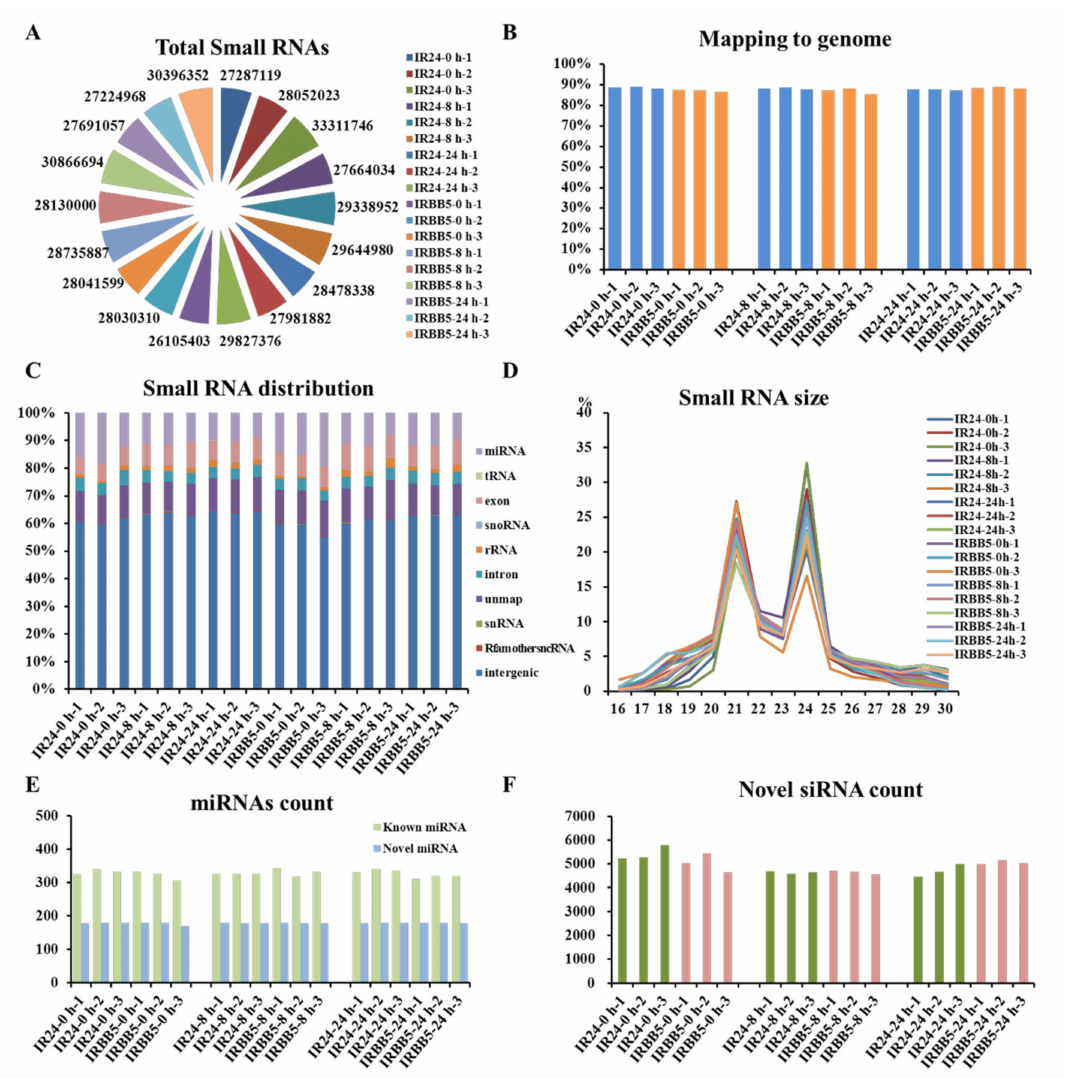
Figure 2. Profiling of small RNA sequencing in two rice genotypes inoculated with Xoo strain PXO86. ( A ) Total clean reads distribution in libraries from di ff erent time point treatment with Xoo strain PXO86. ( B ) The mapping percentage of the clean reads in 18 sequenced samples. ( C ) The classification distribution of the sequenced small RNA for every rice small RNA library. ( D ) Length distribution and abundance of the small RNAs in each library. ( E ) The statistic of known and candidate miRNAs in disparate sample. ( F ) The distribution number of predicted siRNAs in disparate sample. ‘IR24 (cid:48) represents the rice cultivar ‘IR24 (cid:48) ; ‘IRBB5 (cid:48) represents the rice cultivar ‘IRBB5 (cid:48) ; ‘0 h’, ‘8 h’ and ‘24 h’ represents separately the treatment time point with Xoo strain PXO86; ‘ − 1 (cid:48) , ‘ − 2 (cid:48) and ‘ − 3 (cid:48) means the di ff erent biological replicate, respectively; nt,